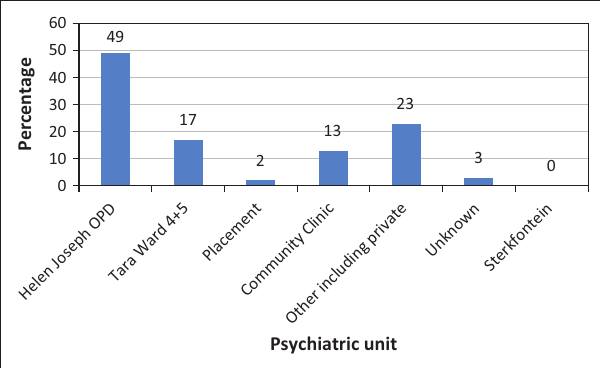
FIGURE 5: Discharge plans for patients with borderline personality disorder admitted to the acute psychiatric unit at Helen Joseph Hospital during